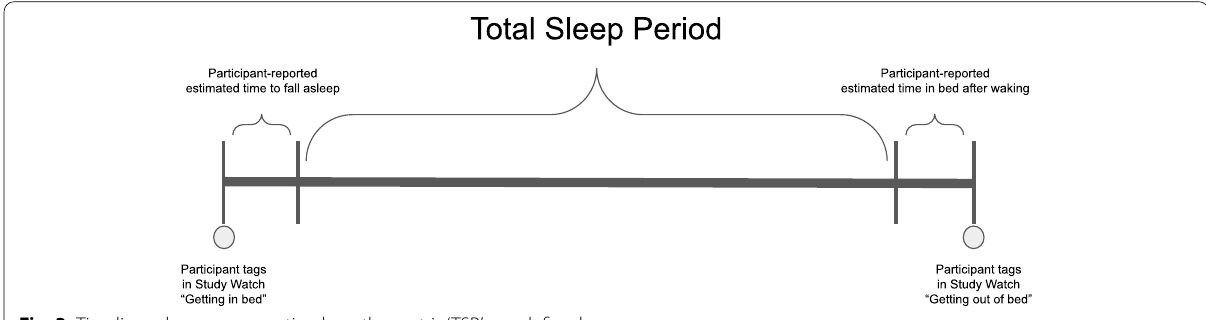
Fig. 3 Timeline schema representing how the metric ‘TSP’ was